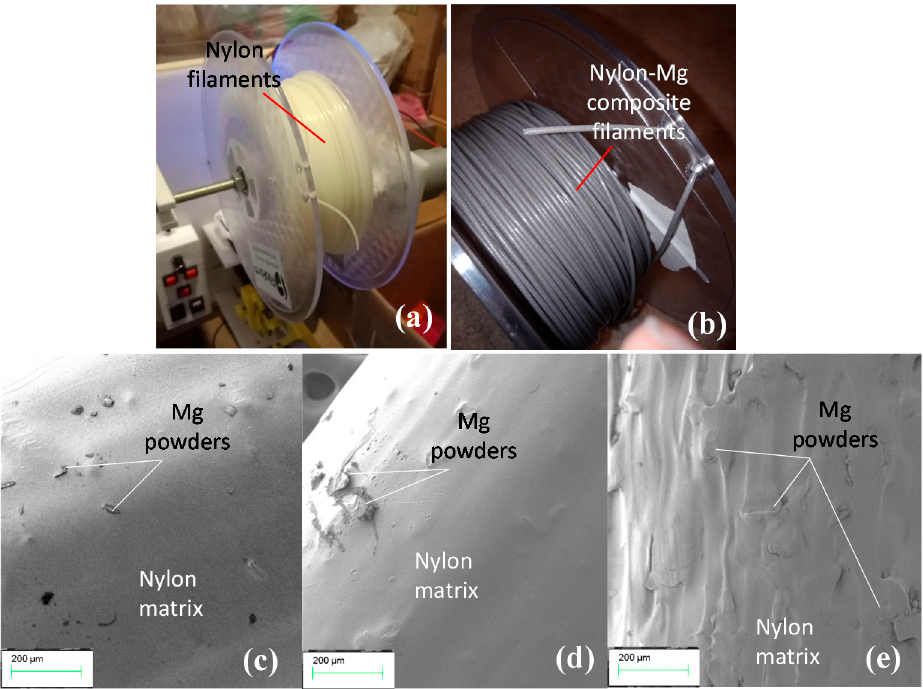
Figure 3. ( a ) Extruded waste nylon filaments; ( b ) Mg composite filaments spools; and SEM imaging of surface topography for ( c ) 2% Mg, ( d ) 4% Mg, and ( e ) 8% Mg composite filaments. Table 1. Filament diameter and moisture